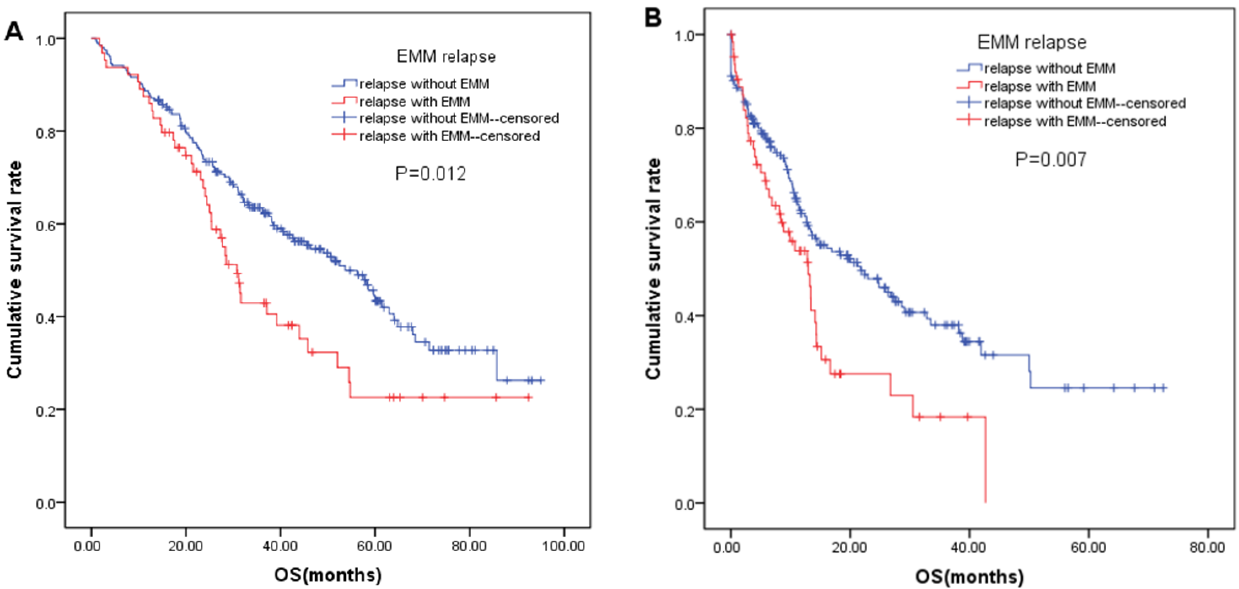
Figure 2. Overall survival (OS) of patients with EMM relapse and relapse without EMM ( A ); OS of relapsed patients ( B ).